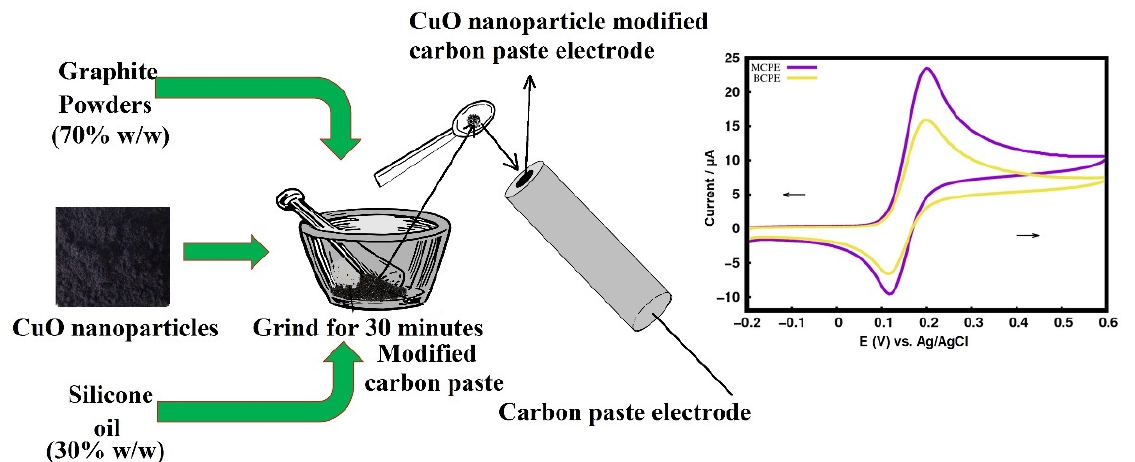
carbon paste electrode.